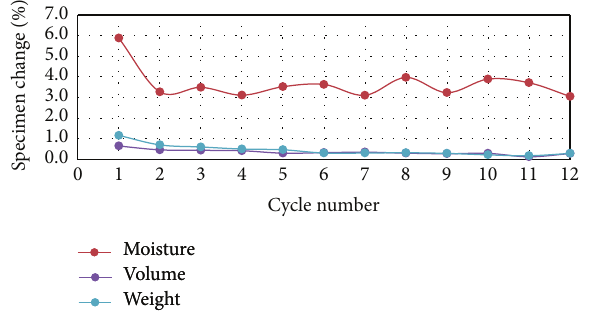
Figure 10: Moisture, volume, and weight changes of CTB.